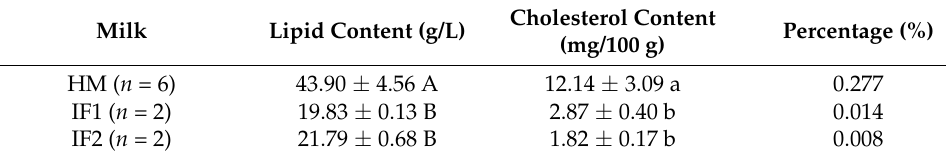
Table 1. Content of lipid and cholesterol of human milk and infant formula. Cholesterol Milk Lipid Content (g/L)